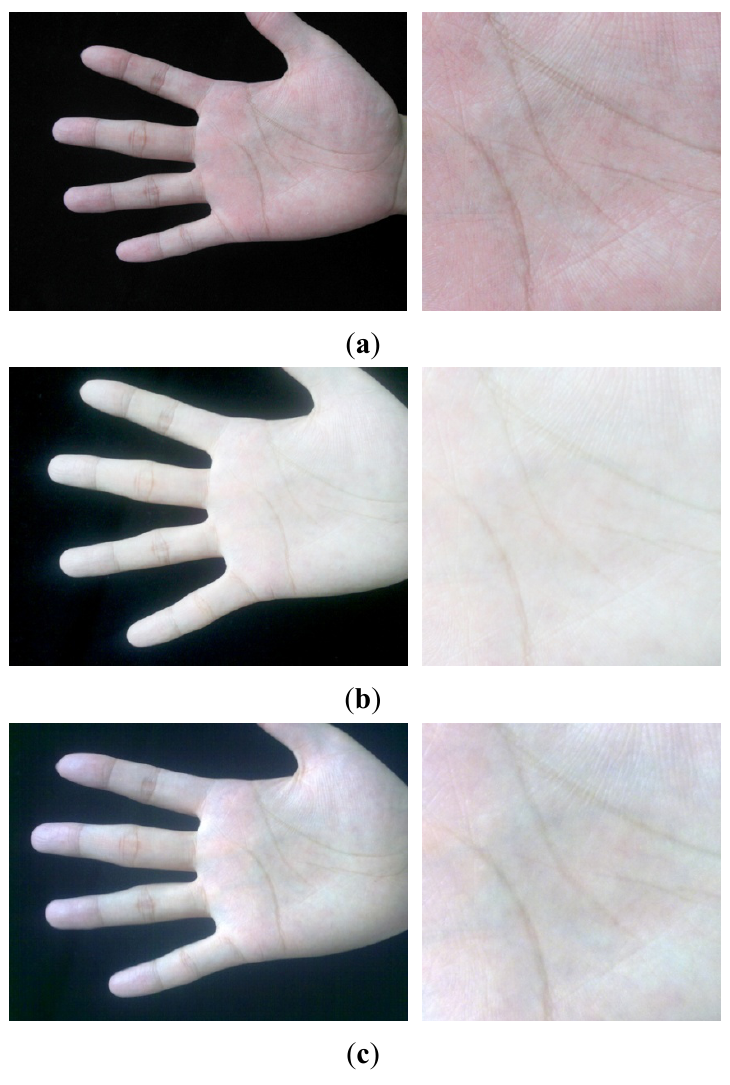
Figure 3. Three palmprint images and corresponding ROI images captured from a same palm by three devices: ( a ) the palmprint images and ROI images captured by the C950 camera; ( b ) the palmprint images and ROI images captured by the M525 smart-phone; ( c ) the palmprint images and ROI images captured by the N5800